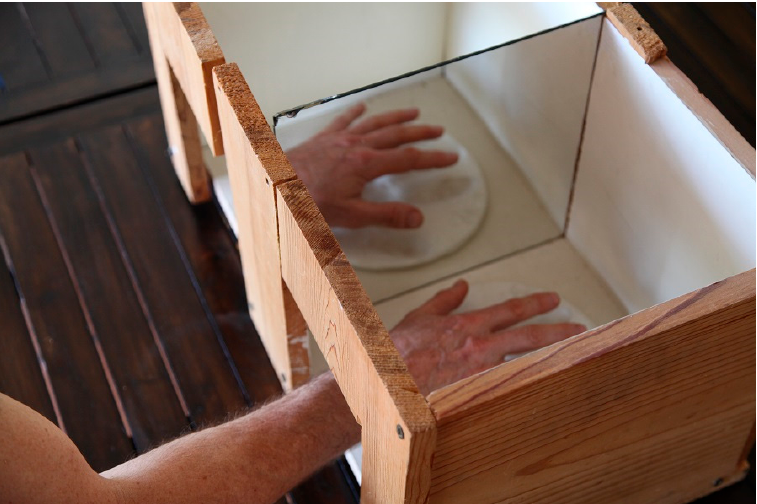
Figure 3. Ramachandran’s original Mirror Box. The amputated hand seems to appear in the other compartment of the box, helping heal pain associated with phantom limb syndrome.